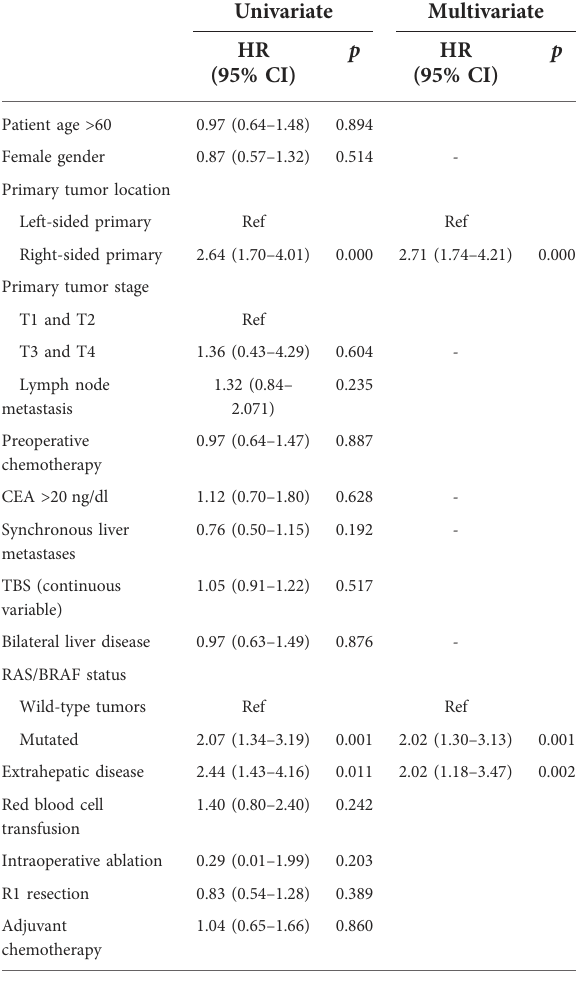
TABLE 5 Univariate and multivariate survival analyses after PSM in patients of TBS <7. Univariate